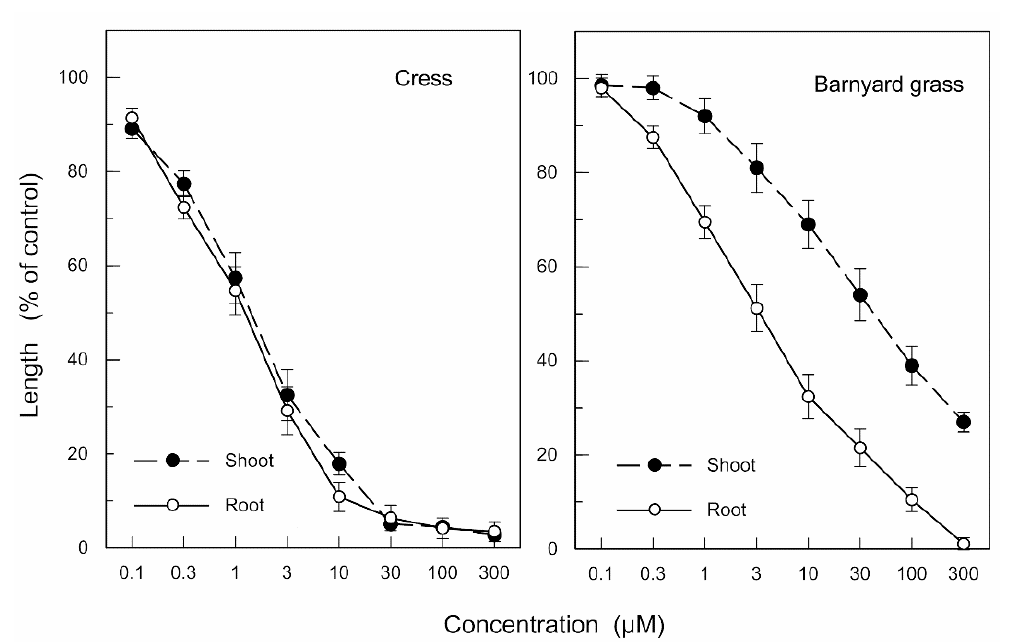
Figure 5. Effects of nimbolide B on the root and shoot growth of cress and barnyard grass. Means ± SE from 4 independent experiments with 10 plants for each determination are